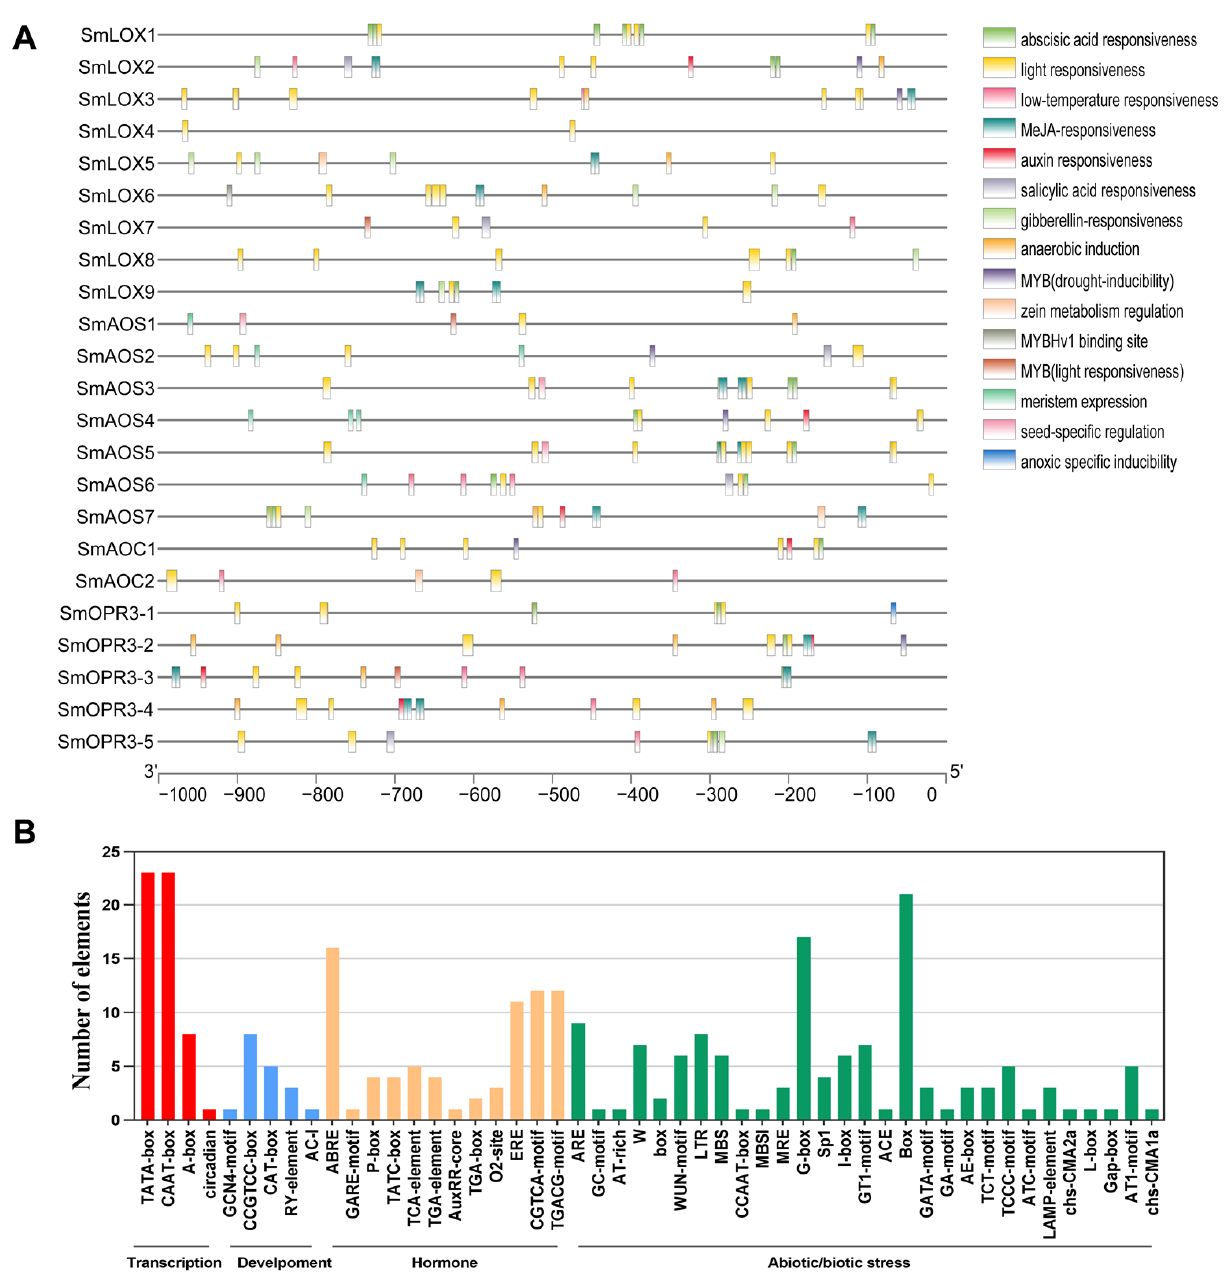
Figure 5. ( A ) Predicted cis -elements in the prompters of JA biosynthesis related genes. Distribution of cis -elements in the 1 kb upstream promoter regions of JA biosynthesis related genes. Different cis -elements are represented by various colors. ( B ) Number of JA biosynthesis related genes containing various cis -acting elements. The cis -acting elements were identified with the online PlantCARE program using 1 kb upstream of transcription initiation sites of JA biosynthesis related genes. The graph was generated based on the presence of cis -acting elements in response to specific elicitors/conditions/processes ( x -axis) in all JA biosynthesis related genes ( y -axis).